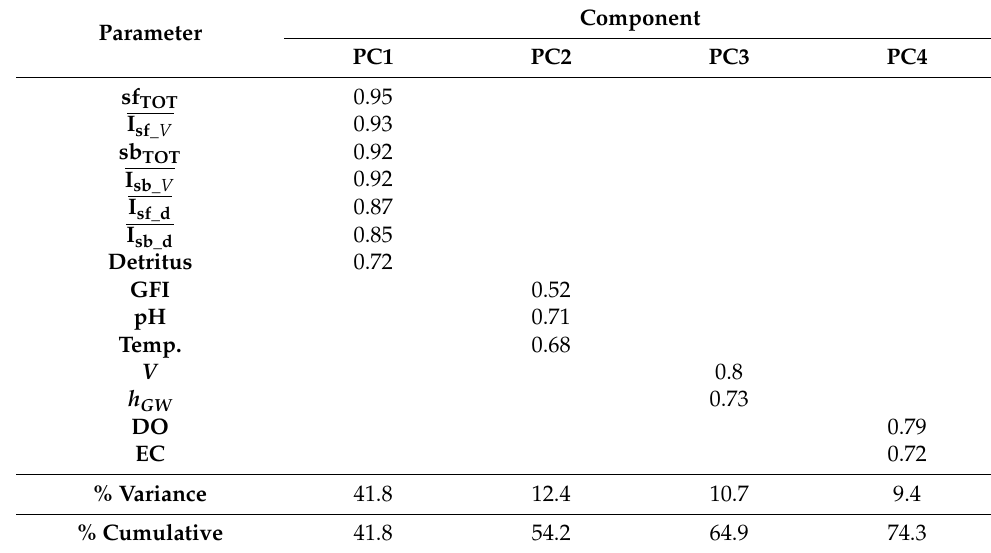
variance (Tables 5 and 6) for BB and SB, respectively. The downward curve scree plots and component plots in rotated space of principal component loadings for both groups of springs are shown in Supplementary Figure S3 and Figure S4. For BB, the percentages of variance explained by the factors are 41.8% for PC1, 12.4% for PC2, 10.7% for PC3, and 9.4% for PC4, whereas for SB, the percentages of variance explained by the factors are 29.8% for PC1, 16.1% for PC2, 15% for PC3, and 9.9% for PC4. High positive loadings (Pearson correlation coefficient) of different variables on the same factor may indicate a close relationship among the respective variables, whereas negative loadings between variables indicate an inverse relationship. Table 5. Principal component loadings from 14 variables for 80 samples collected from November 2018 to October 2019 in five sampling campaigns in Baumberge (correlation coefficients of loadings at corresponding factors are significant at p ≤ 0.01 (two-tailed)).